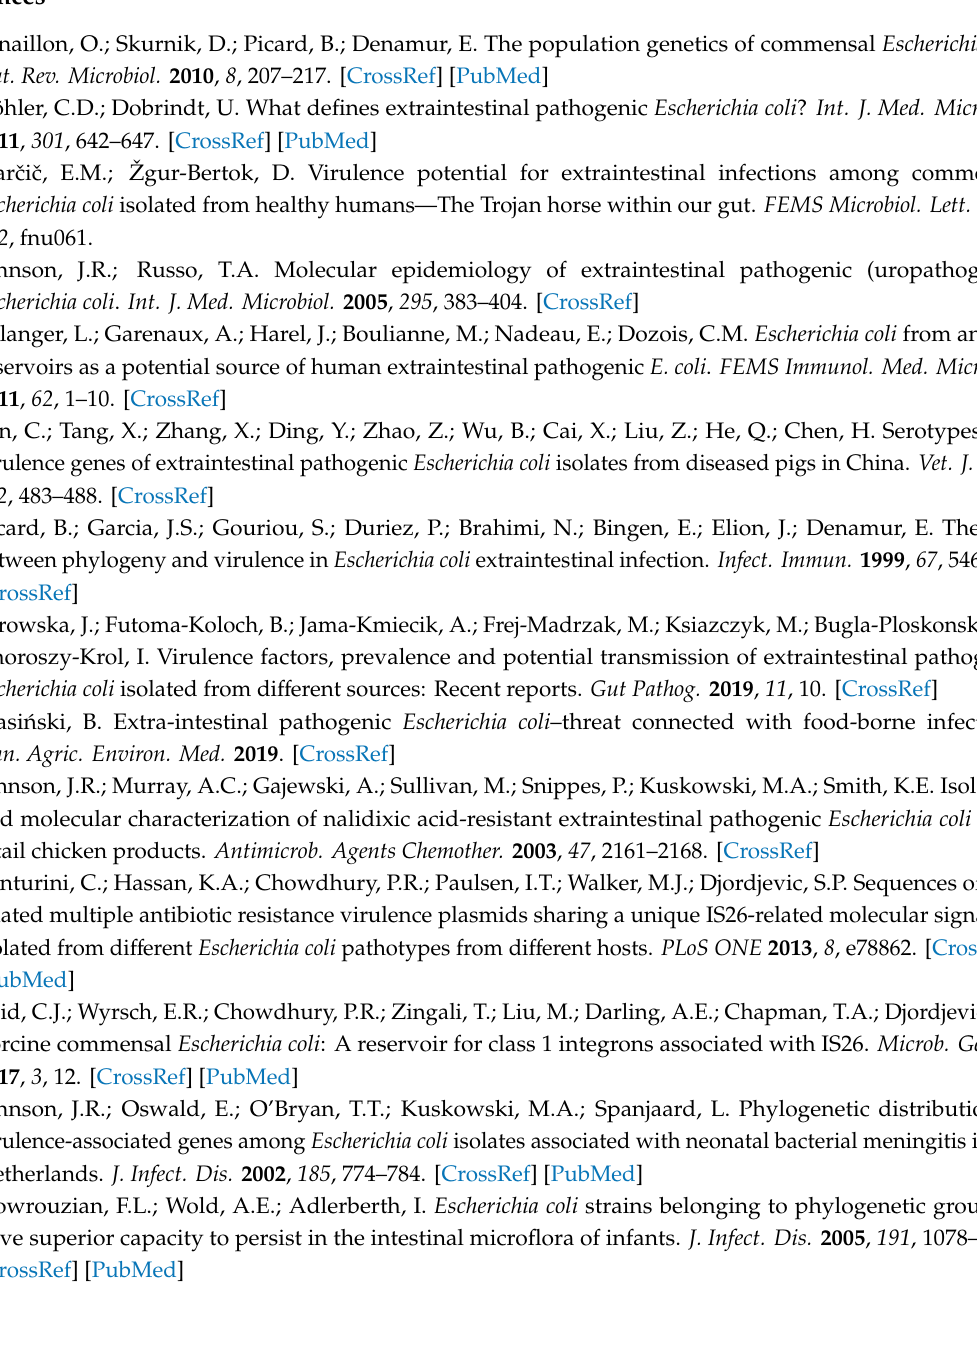
Table S1: Comparison of phylogenetic structure of E. coli isolates from piglets and sows using previous and revised Clermont phylogenetic typing